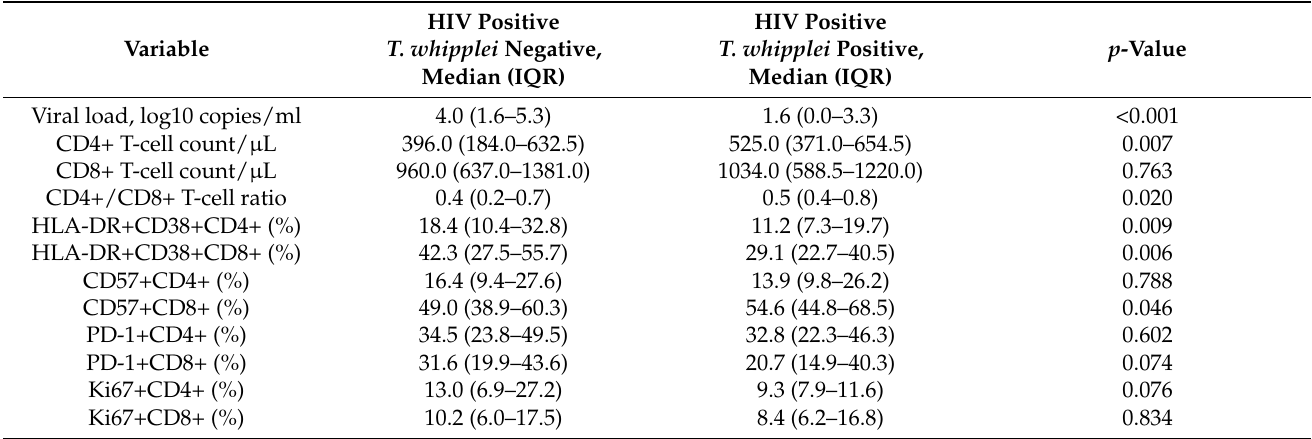
Table 2. Virological and immunological parameters according to T. whipplei status.